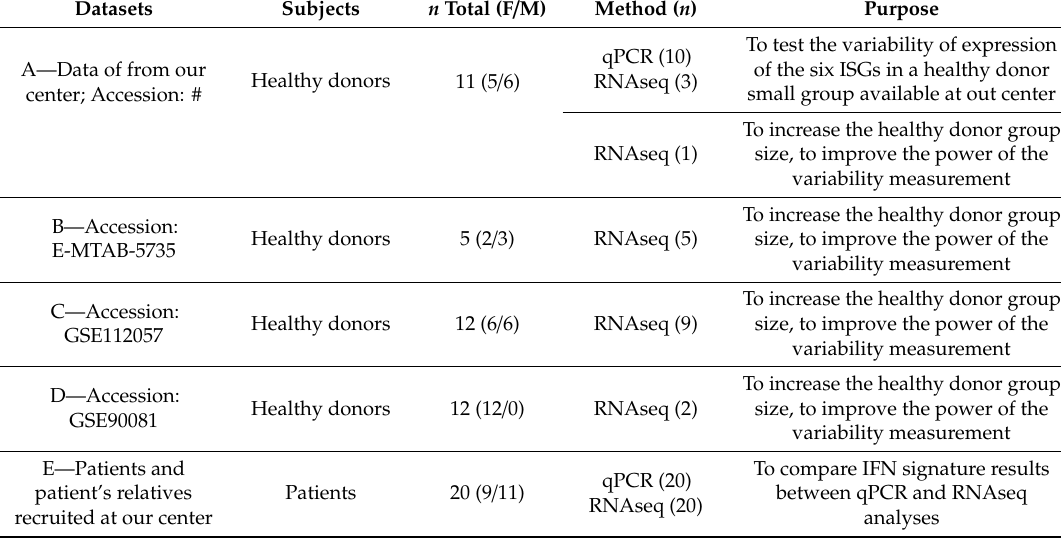
Table 1. Dataset composition: subjects, size, methods and